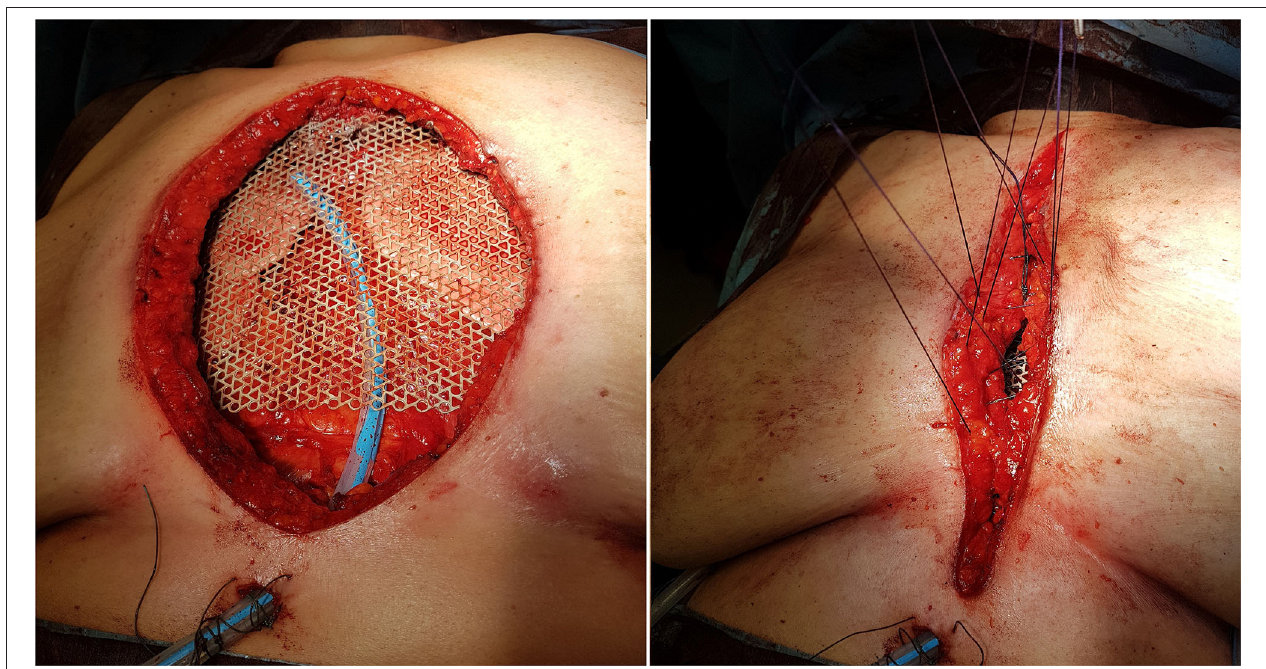
FIGURE 1 | Shaped titanium mesh that entirely covers the anterior wall